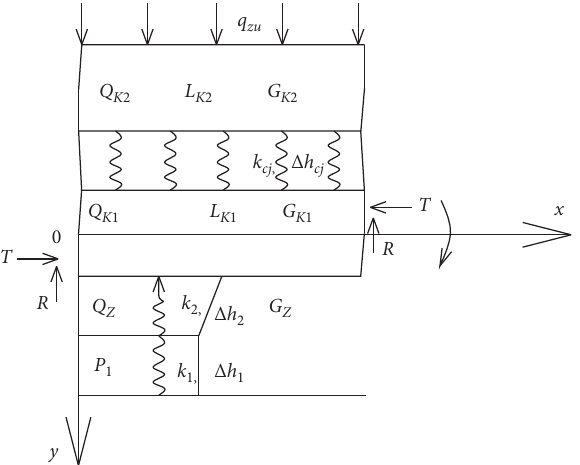
Figure 7: Mechanical model of fracture columns in combination key